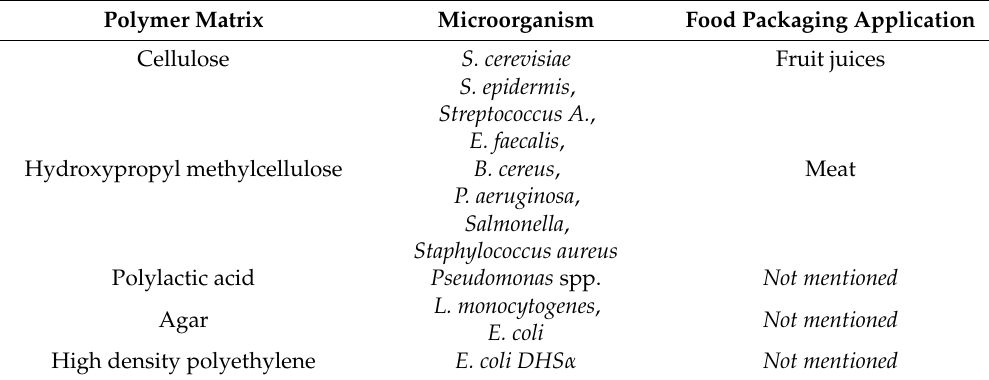
Table 2. Main applications of copper-polymer nanocomposites